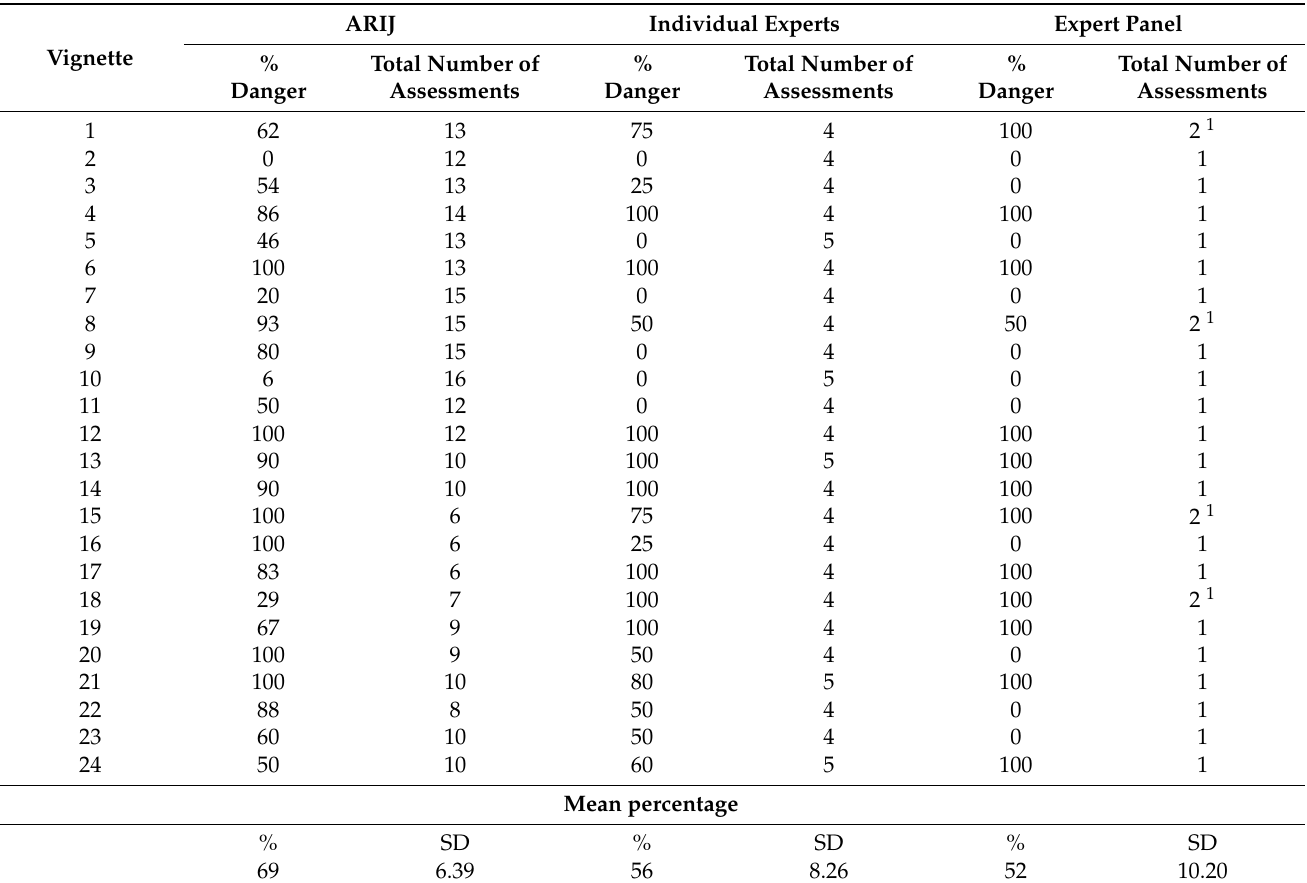
Table 1. Prevalence of the safety decision immediate danger for the ARIJ assessments, the individual expert assessments, and the expert panel